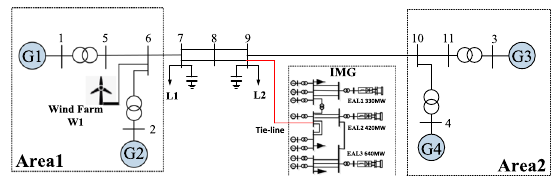
Fig. 9 Two-area power system connected with the IMG